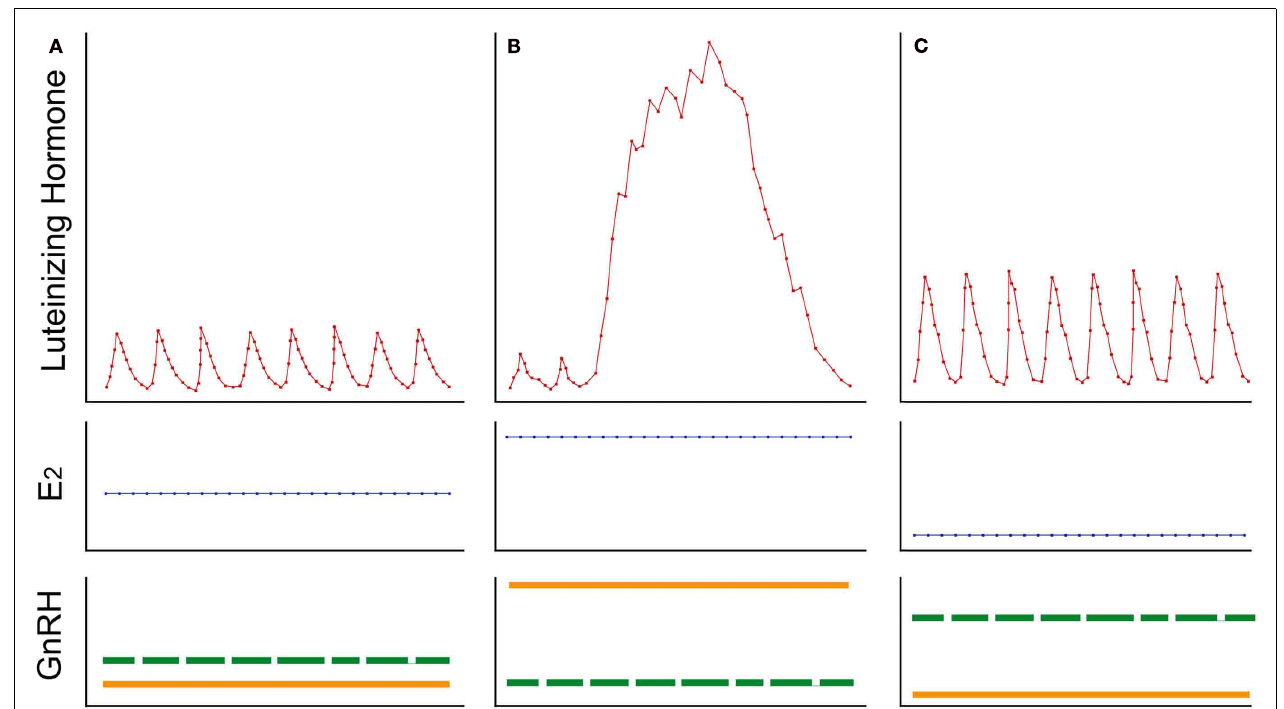
FIGURE 6 |A summary of the hypothesized mechanism by which estradiol (E 2 ) modulates luteinizing hormone (LH) release in female primates. Stylized representations of three distinct temporal patterns of LH release are depicted in the upper panels, while corresponding plasma E 2 levels and GnRH neuronal activity are represented in the middle and lower panels, respectively. (A) Low amplitude pulse of LH are typically observed during the follicular phase of the menstrual cycle; this is associated with low-to-medium plasma E 2 levels, which exert a moderate degree of negative feedback onto GnRH-I neurons (represented by the dashed green line) but cause little stimulation of GnRH-II neurons (represented by the solid orange line). (B) An LH surge typically occurs in the middle of the menstrual cycle; this is associated with high plasma E 2 levels, which inhibit GnRH-I neuronal activity